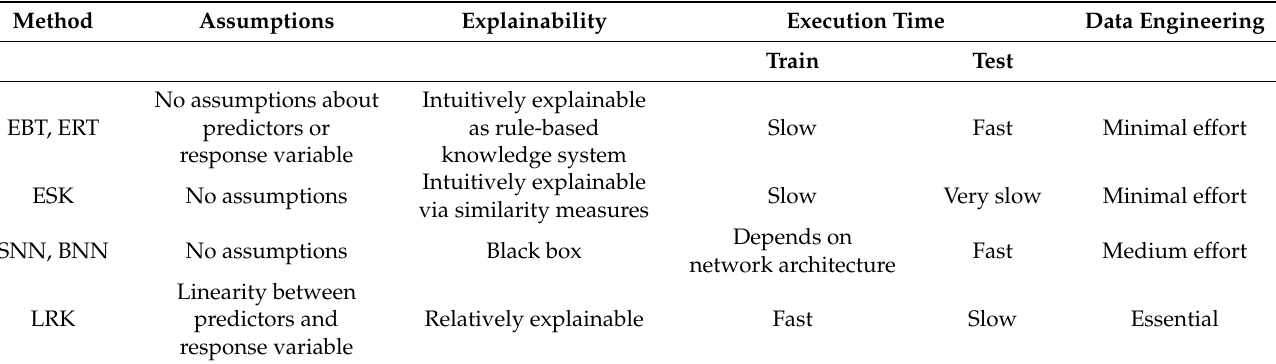
Table 1. Machine-learning algorithms selection